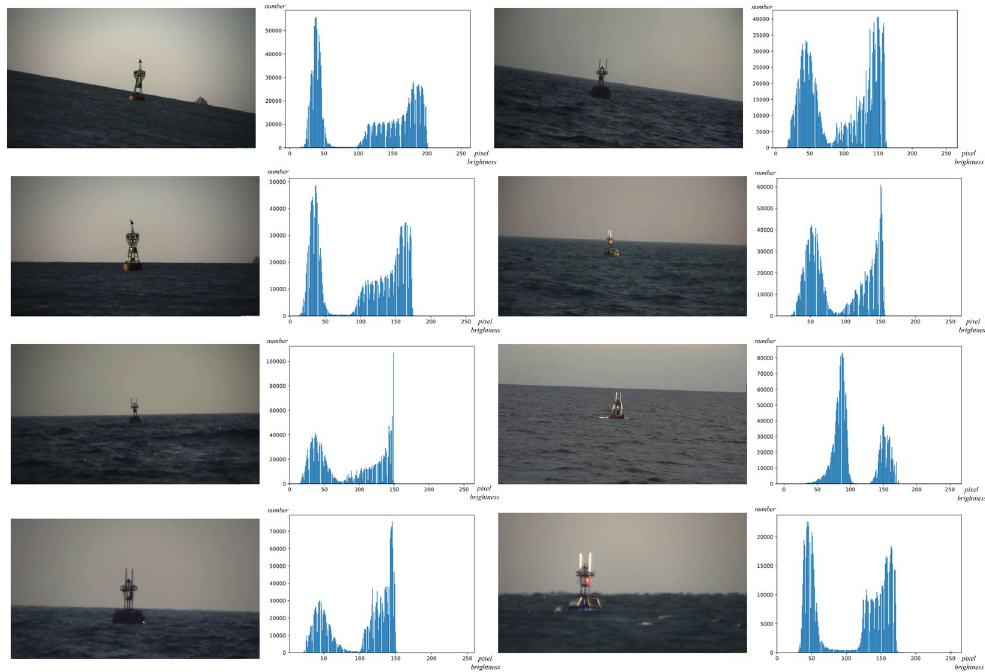
Figure 3. Fog-free image at sea and its grayscale histogram.